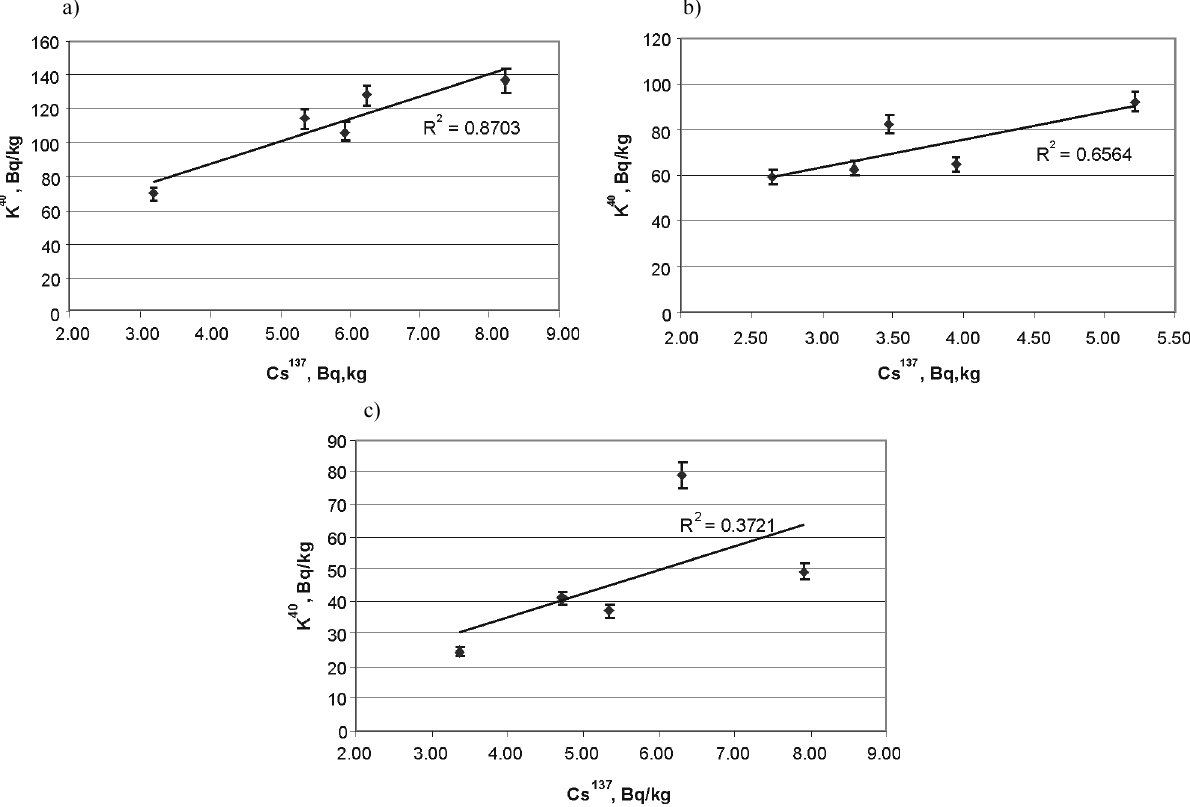
137 40 Cs and K activity concentrations in fox muscle (a), bones (b), and liver